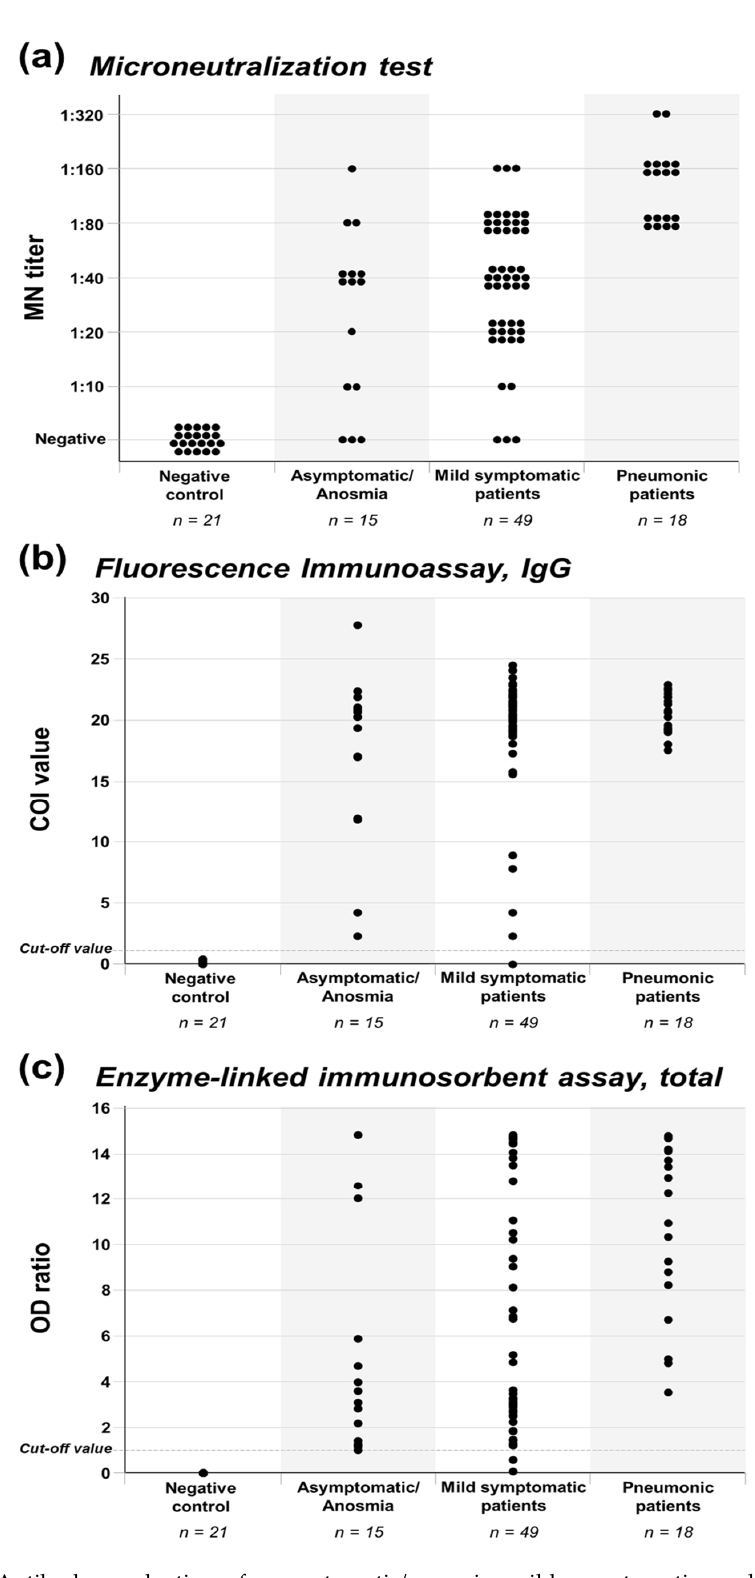
Figure 1. Antibody production of asymptomatic/anosmia, mild symptomatic, and pneumonic COVID-19 patients. Antibody production of asymptomatic/anosmia, mild symptomatic, and pneumonic COVID-19 patients was evaluated by ( A ) MN, ( B ) FIA IgG, and ( C ) ELISA methods.